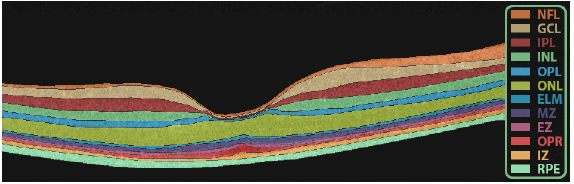
Figure 2. Segmentation of the retinal layers.